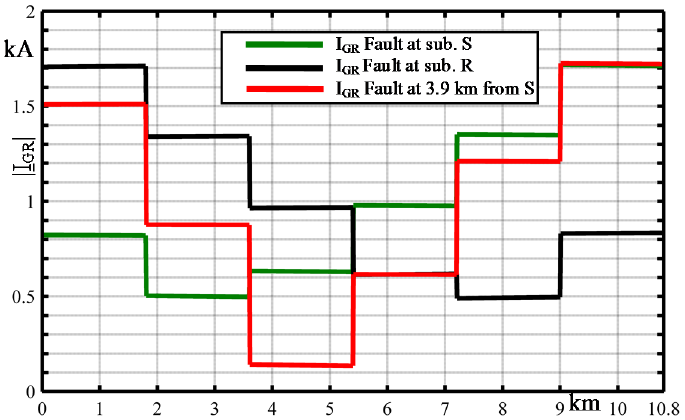
Figure 8. Faulted UGC: ground return current magnitudes along the line (CB with PTs) for different fault locations.